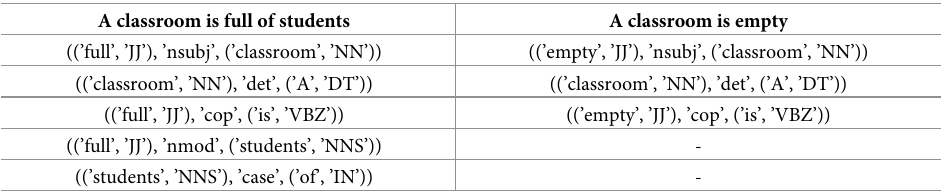
Table 1. Results produced by the Stanford